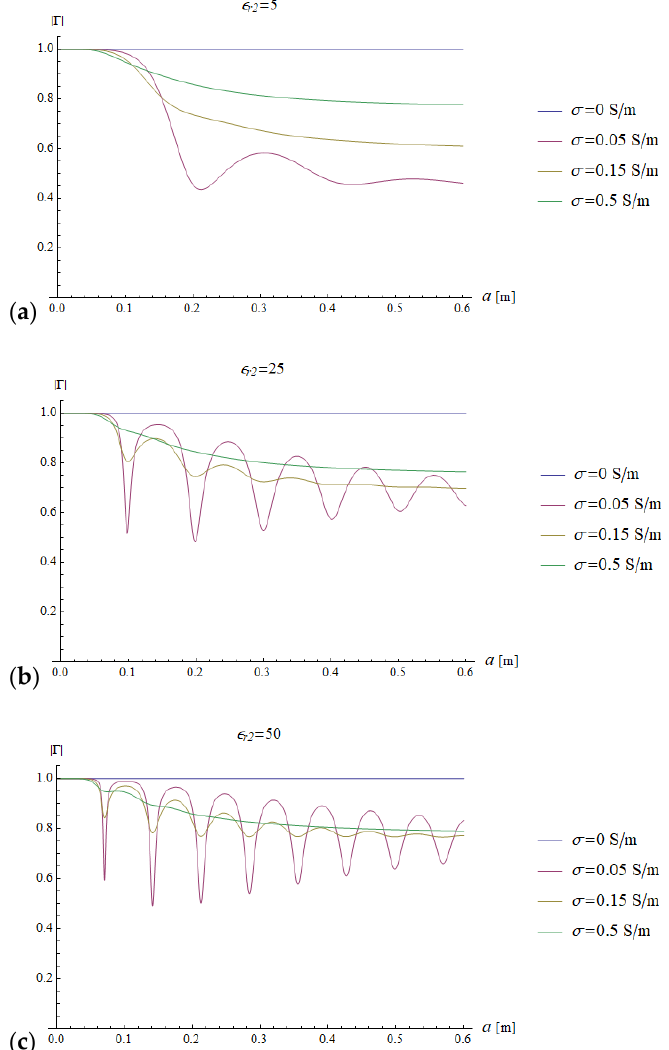
Figure 4. The modulus of the reflection coefficient is plotted as a function of the sphere radius for different values of relative permittivity ( ε r 2 = 5, 25 and 50 in ( a – c ), respectively) and conductivity ( σ = 0, 0.05, 0.15 and 0.5 S/m). The frequency is set to 297.2 MHz.